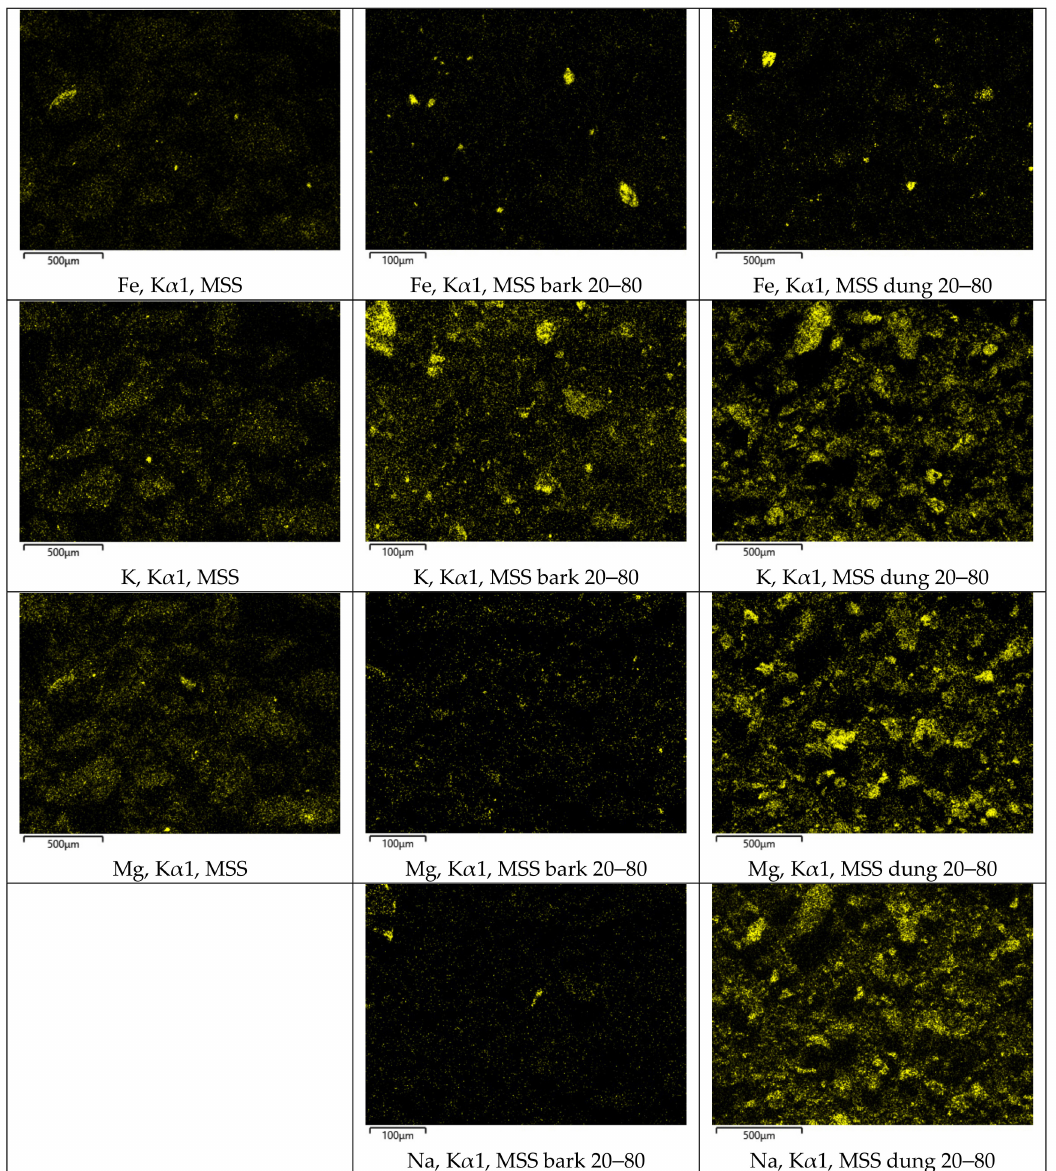
Figure 6. SEM-EDX images for ash samples MSS, MSS bark 20–80 and MSS dung 20–80. Specific areas for P association analysis are marked with numbers in each electron